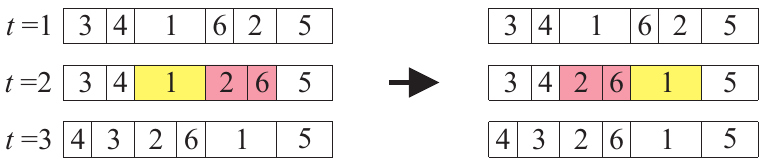
Figure 2. Relocating facility 1 from position 3 to position 5 during planning period